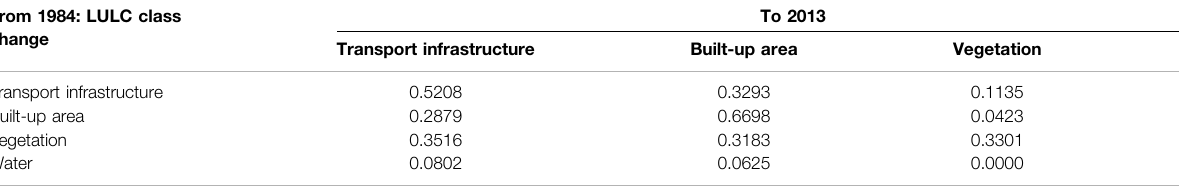
TABLE 5 | Transition probability matrix of LULC changes from 1984 to 2013.